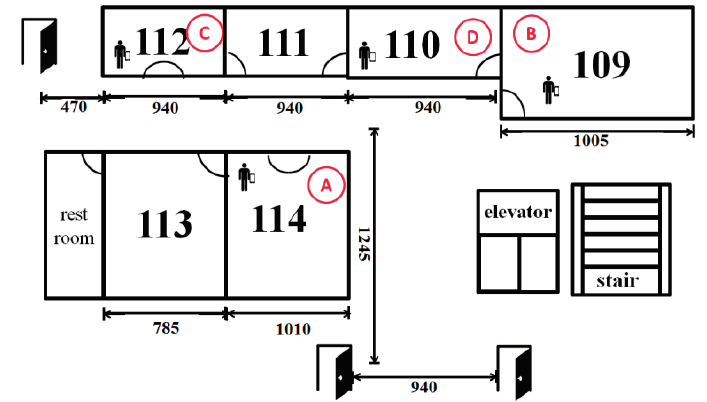
Figure 14. Experiment